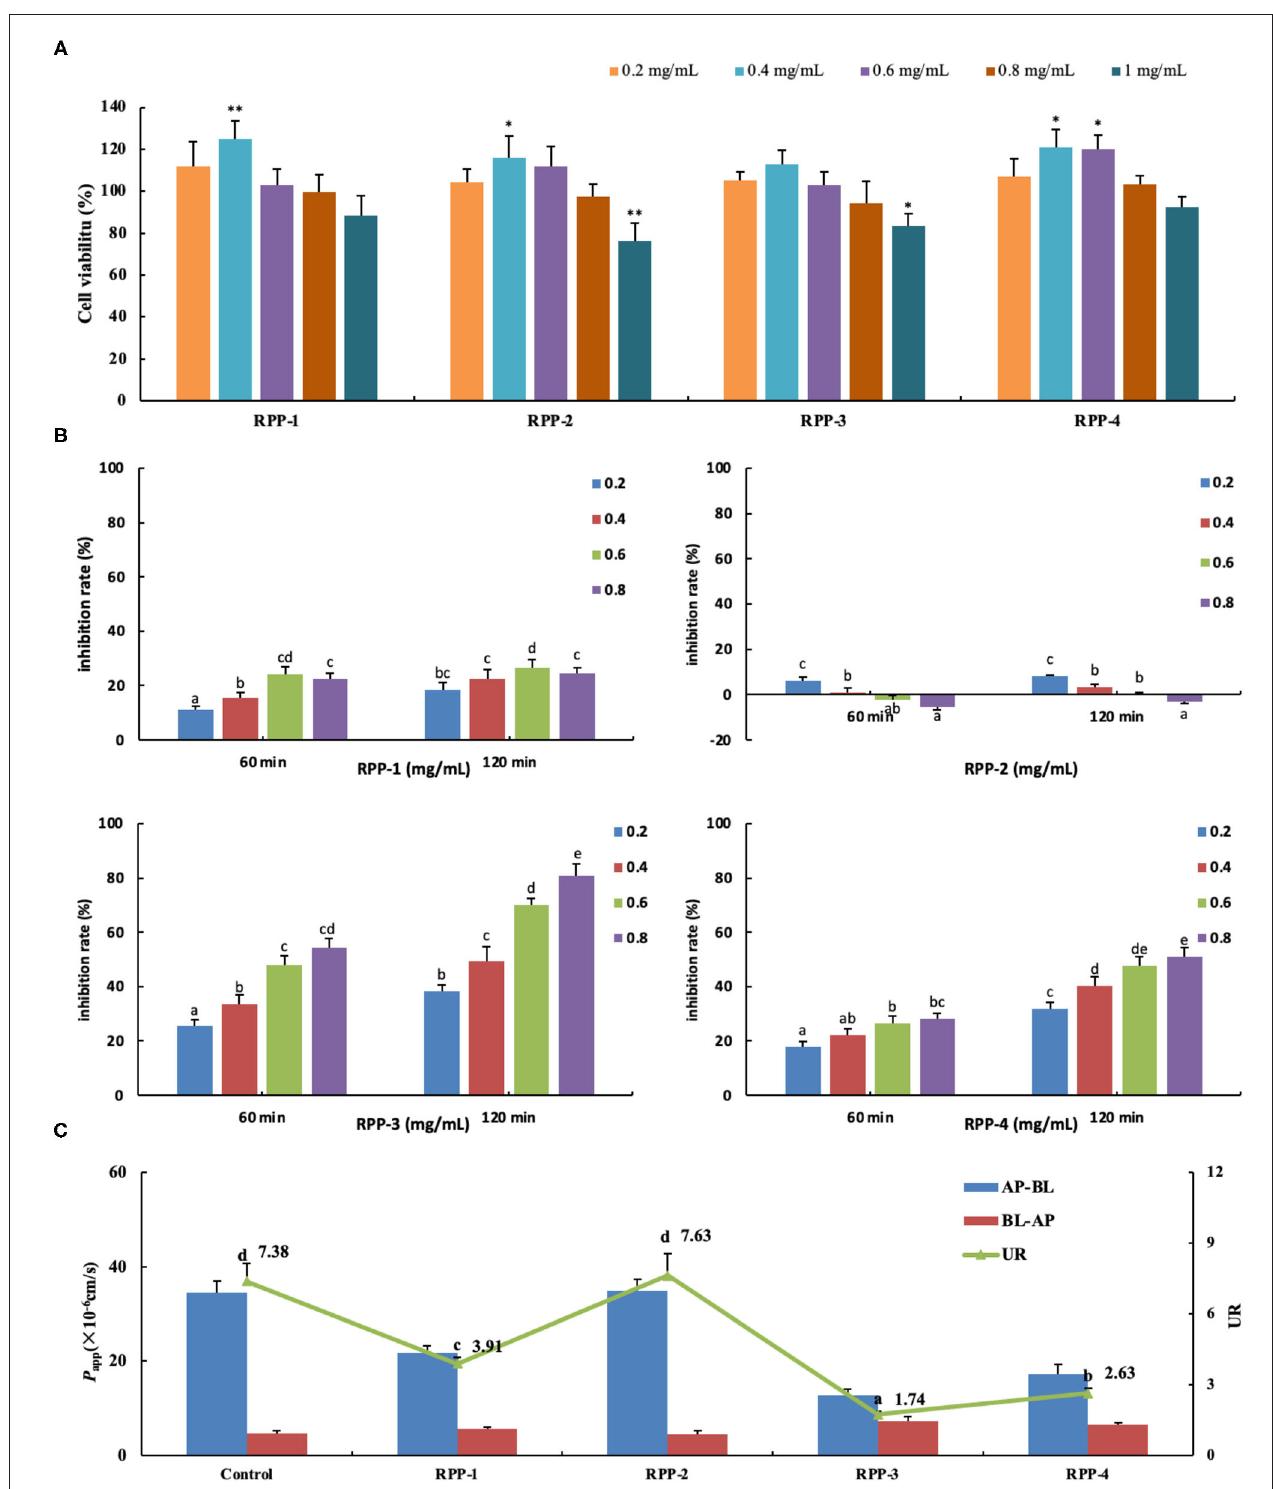
FIGURE 6 | Pumpkin polysaccharide RPPs on the glucose uptake and transport across Caco-2 cell monolayer. (A) RPPs on the activity of colon cancer cells Caco-2. (B) Inhibition rate of RPPs on Caco-2 glucose uptake. (C) RPPs on the transport of glucose across Caco-2 cell monolayer. Each point represents the mean ± SD for at least three independent monolayers (a < b < c < d < e, all p < 0.01). RPPs, refined pumpkin polysaccharides; UR, uptake ratio.